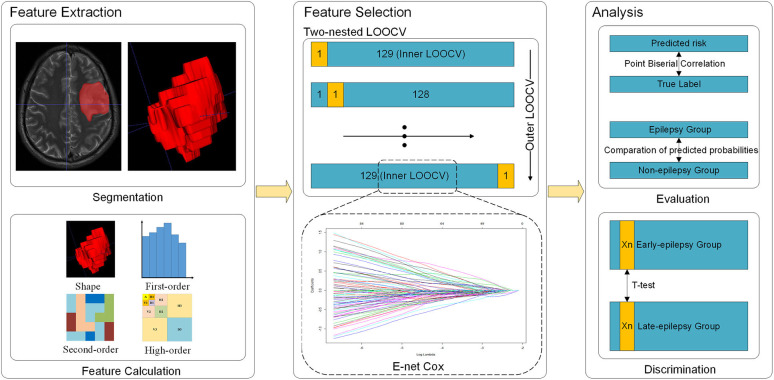
Flow chart of the study.